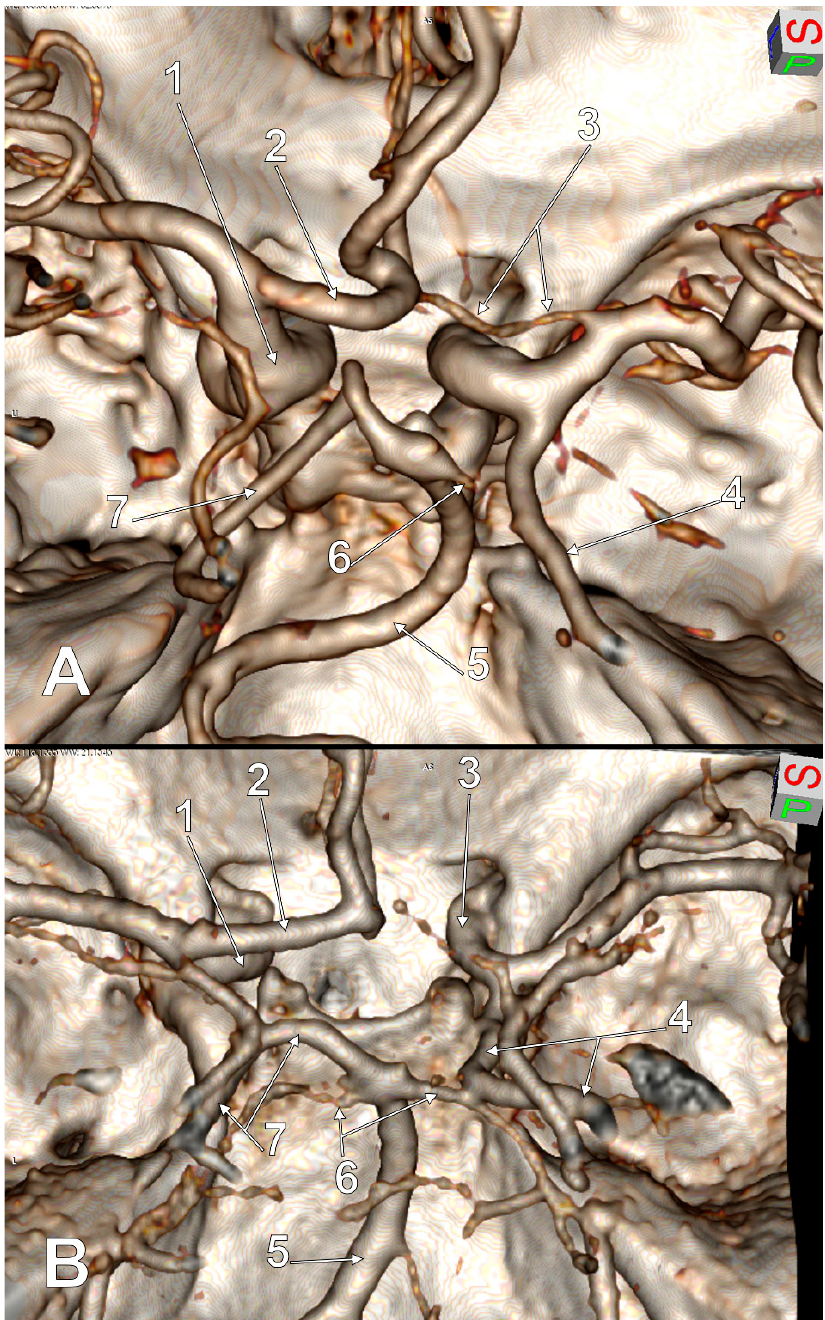
Figure 6. Postero-superior views of the cW. Unilateral full/complete FPCAs (f-FPCA). Three variant sides of the cW. ( A ). Hypoplastic right A1, ipsilateral aplasia of P1, contralateral aplasia of PComA. 1. Left ICA; 2. A1 segment of the left ACA; 3. Hypoplastic A1 segment of the right ACA; 4. Right f-FPCA; 5. BA; 6. Right superior cerebellar artery; 7. Left PCA. ( B ). Right aplasia of A1 and P1, left aplasia of PComA. 1. Left ICA; 2. A1 segment of the left ACA; 3. Right ICA; 4. Right f-FPCA; 5. BA; 6. Superior cerebellar arteries; 7. Left PCA.